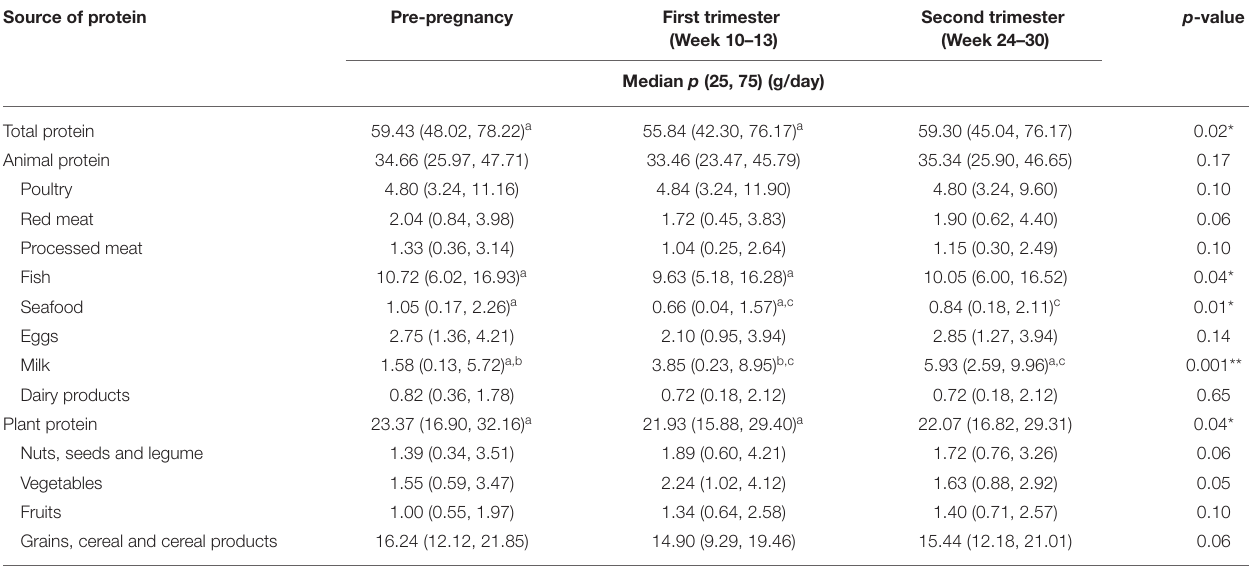
TABLE 2 | The types and sources of protein intake before and during pregnancy. Source of